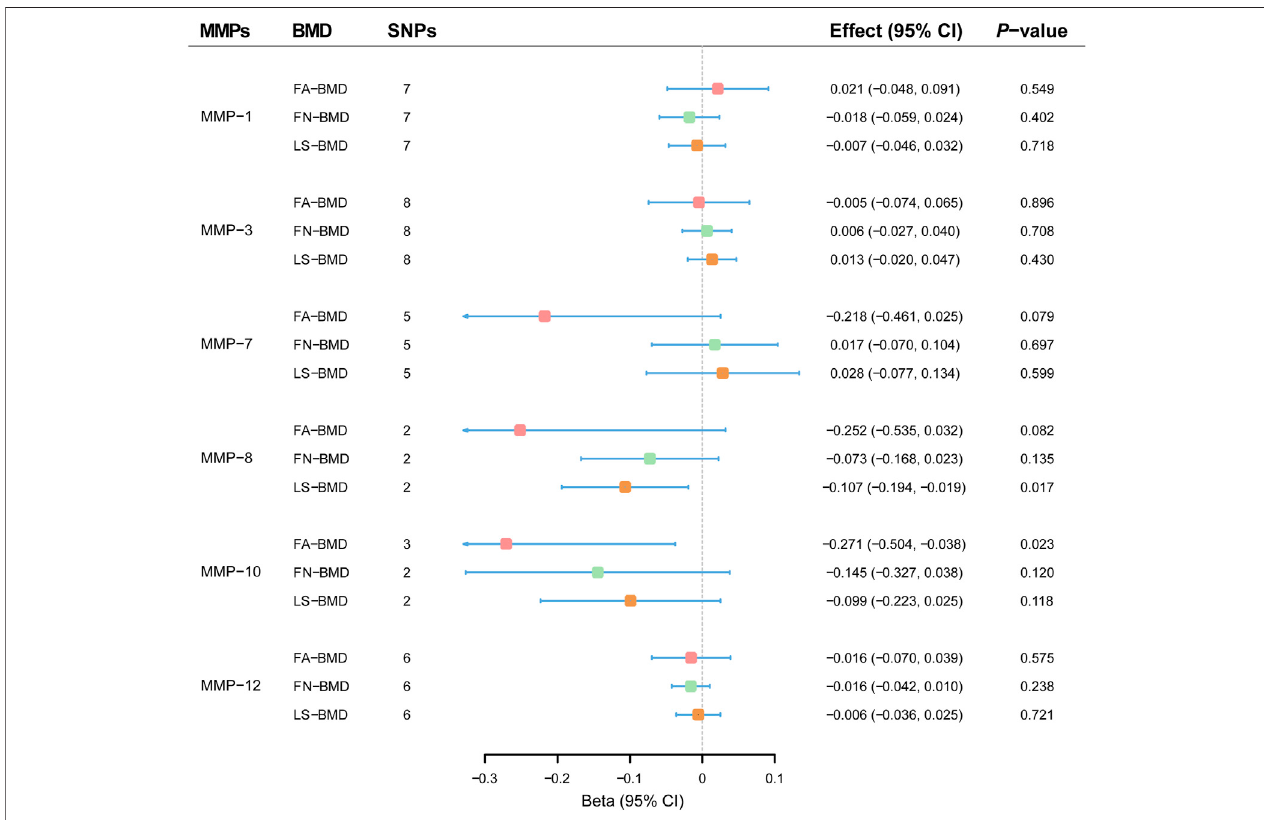
FIGURE 2 | Effect estimates of matrix metalloproteinases on bone mineral density in the Mendelian randomization study. BMD, bone mineral density; CI; con fi dence interval; FA, forearm; FN, femoral neck; LS, lumbar spine; MMP; matrix metalloproteinase; SNP, single nucleotide polymorphism.